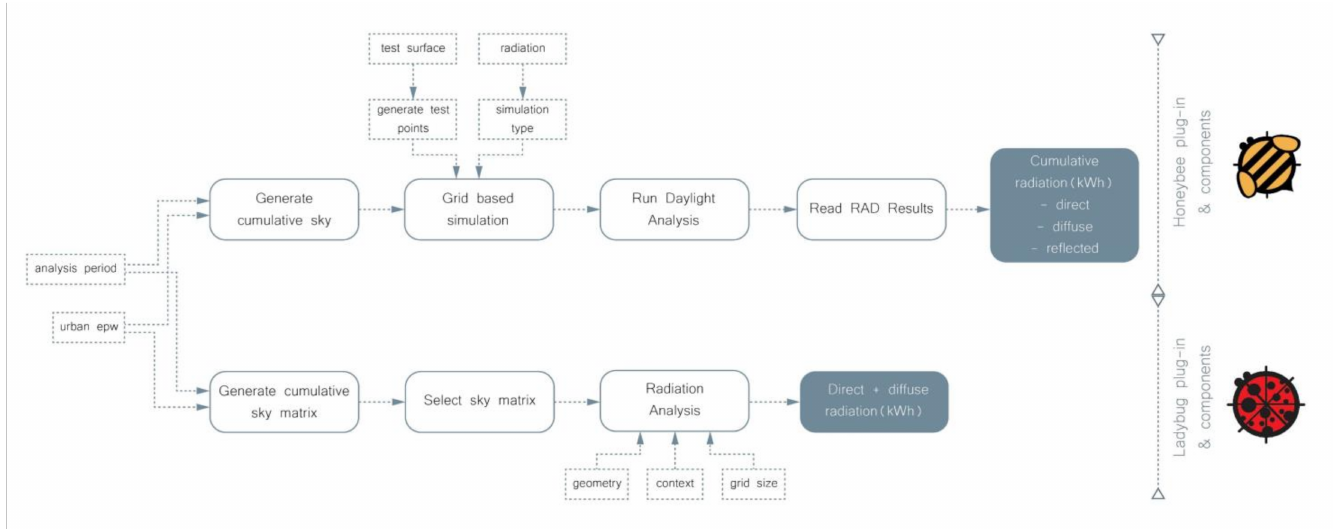
Figure 9. Flowchart of the two workflow approaches for the radiation analysis study and the design tools used for each